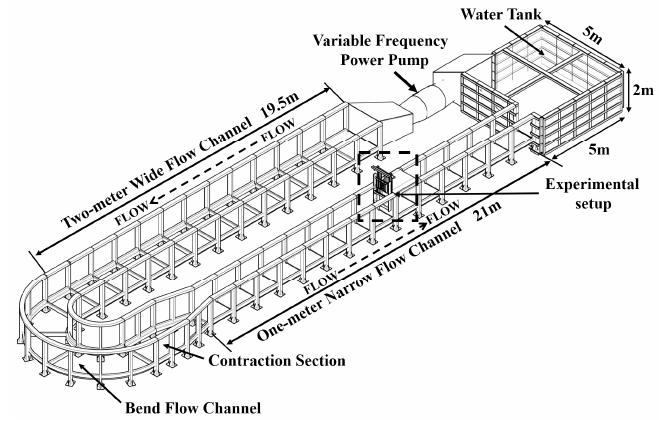
Figure 1. Recirculating water channel system.